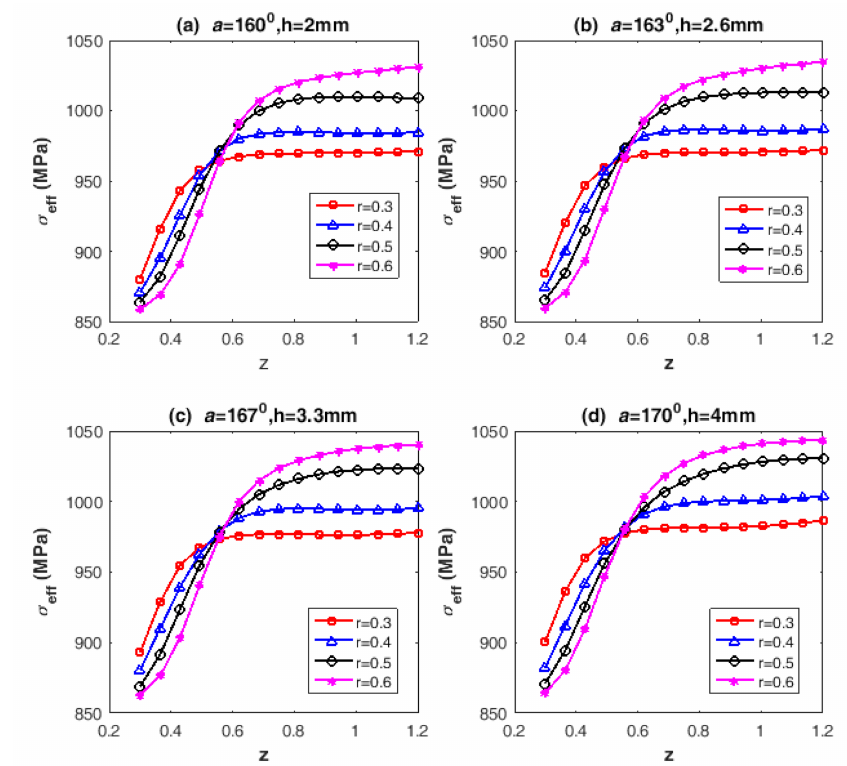
Figure 7. E ff ect of billet size ratio on the e ff ective stress in the billet with varying reduction ratios, punch angle ( a ), and land height (h) at ( a ) a = 160 ◦ , h = 2.0 mm; ( b ) a = 163 ◦ , h = 2.6 mm; ( c ) a = 167 ◦ , h = 3.3 mm; and ( d ) a = 170 ◦ , h = 4.0 mm.